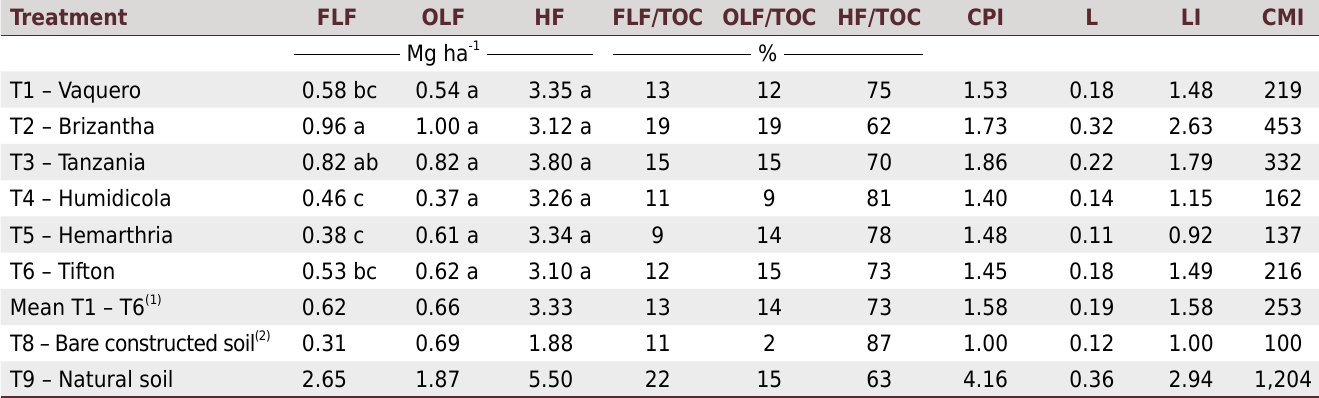
Table 3. Carbon stocks in the free light fraction (FLF), occluded light fraction (OLF), heavy fraction (HF), FLF/TOC, OLF/TOC and HF/TOC ratios, carbon pool index (CPI), carbon lability (L), lability index (LI) and carbon management index (CMI) in the 0.00-0.03 m layer of a constructed soil covered with different grass species, a bare constructed soil and a natural soil (unmined, with native vegetation)